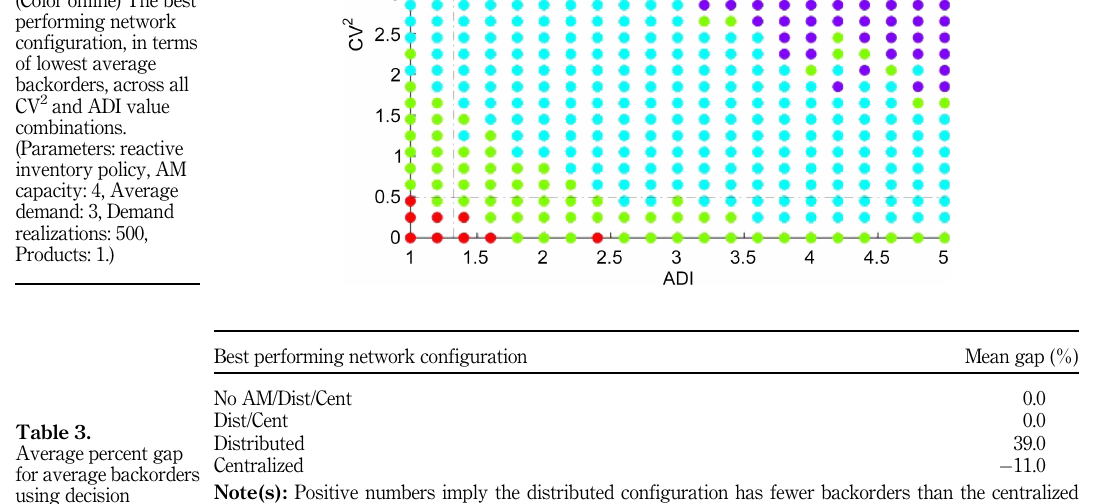
Figure 10. (Color online) The best performing network configuration, in terms of lowest average backorders, across all CV 2 and ADI value combinations.